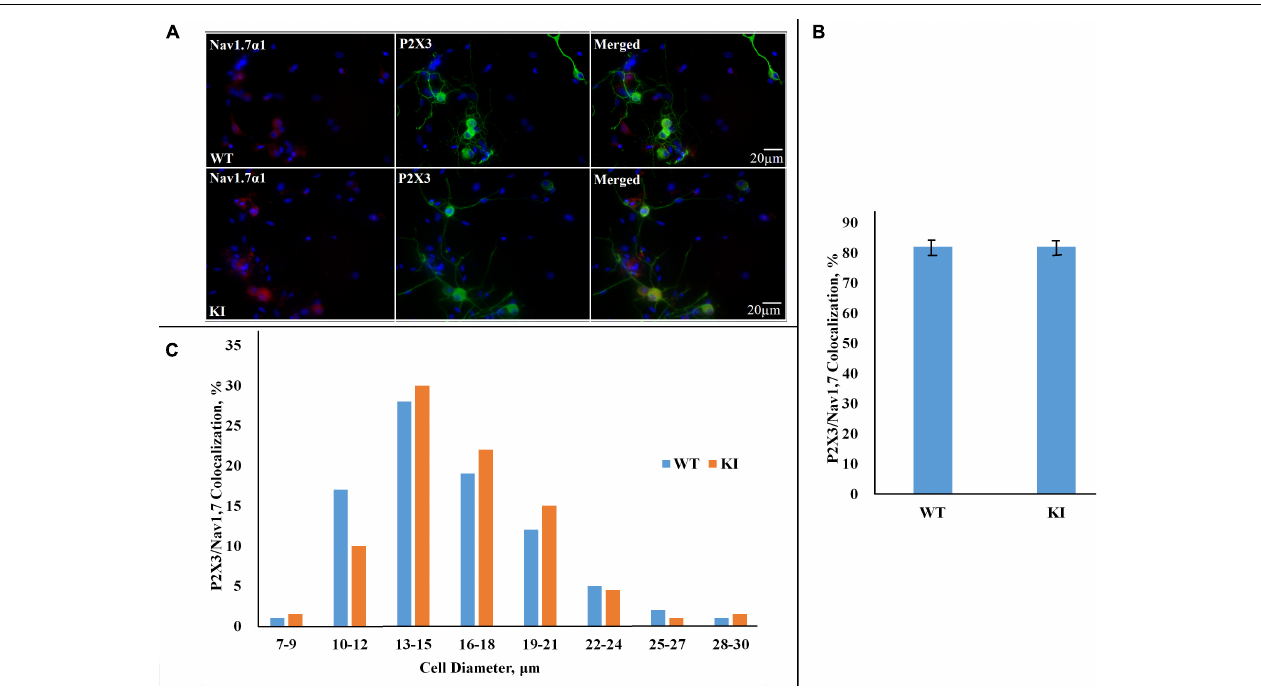
FIGURE 3 | Co-expression of Na V 1.7 α 1 subunit and P2X3R in WT and R192Q KI cultures. (A) Representative examples of Na V 1.7 α 1–P2X3 immunostaining in WT and R192Q KI mouse TG cultures. Nuclei are visualized with DAPI (blue); scale bar = 20 µ m. Note the extensive co-staining of Na V 1.7 α 1 (red) and P2X3 (green) protein in both WT and KI samples. (B) Histograms represent percentage co-expression of Na V 1.7 α 1–P2X3 proteins in WT and KI cultures ( p = 0.95, Mann–Whitney test; n = 3 experiments). (C) The histograms quantify the cell diameter distribution of Na V 1.7 α 1–P2X3R immunofluorescence in different subgroups in WT and KI